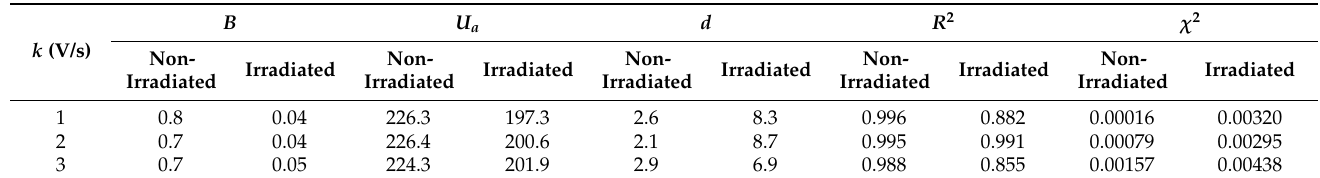
Table 2. Weibull distribution parameters, R 2 and χ 2 coefficients for CITEL GFSA without and in the presence of gamma radiation.